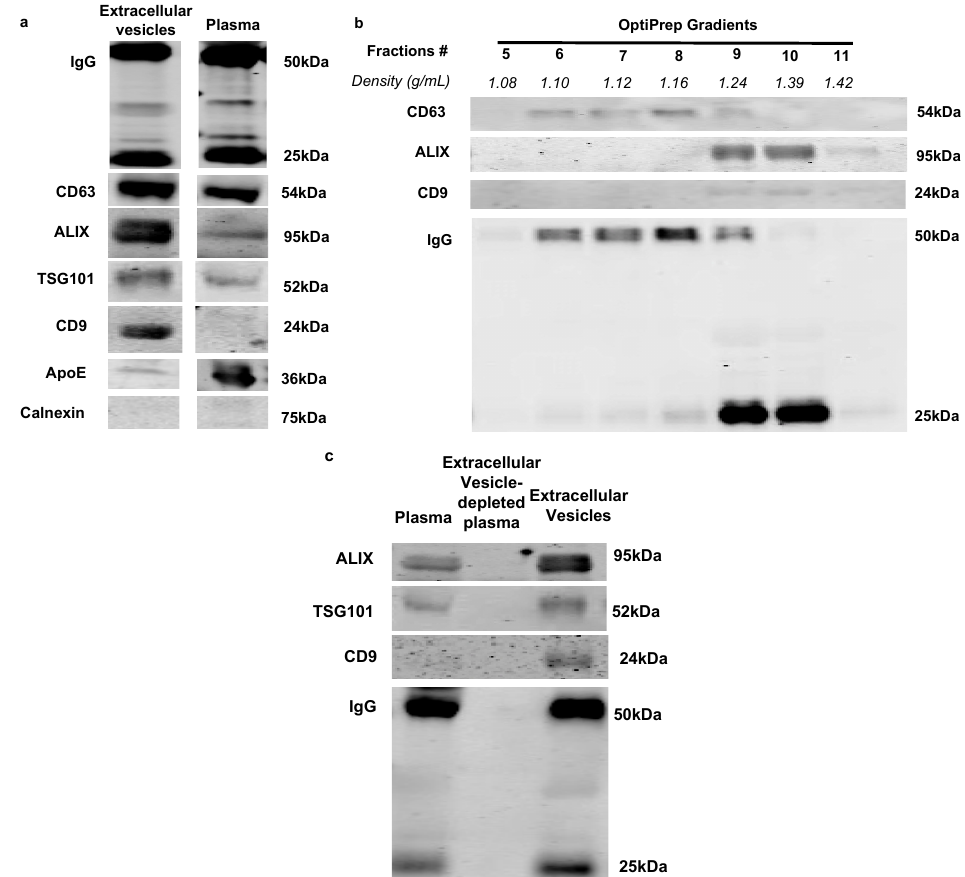
Figure 1. Characterization and specificity of immunoglobulin binding to extracellular vesicles. ( a ) Western blot analysis of rat plasma and ultracentrifugation isolated extracellular vesicles under equal loading volume condition; isolated rat plasma extracellular vesicles showed an enrichment of extracellular vesicle markers (CD63, ALIX TSG101, CD9) compared to whole plasma. The specificity of extracellular vesicle isolation is confirmed using lipoprotein marker (ApoE) and endoplasmic reticulum (ER) marker Calnexin. ( b ) Western blot analysis of extracellular vesicles with OptiPrep density gradient separation post-ultracentrifugation isolation. Extracellular vesicle markers CD63, ALIX and CD9, as well as Immunoglobulin, are present in fractions with 1.10–1.39 g/mL density (fractions 6 to 10). ( c ) Immunoglobulin is removed in extracellular vesicle-depleted plasma (middle lane) via combined ExoQuick and ultracentrifugation methods. All the results were repeated in three different experiments and cropped images in ( a ) between plasma and extracellular vesicles were from the same membrane and uncropped images can be found in Supplementary Figures.